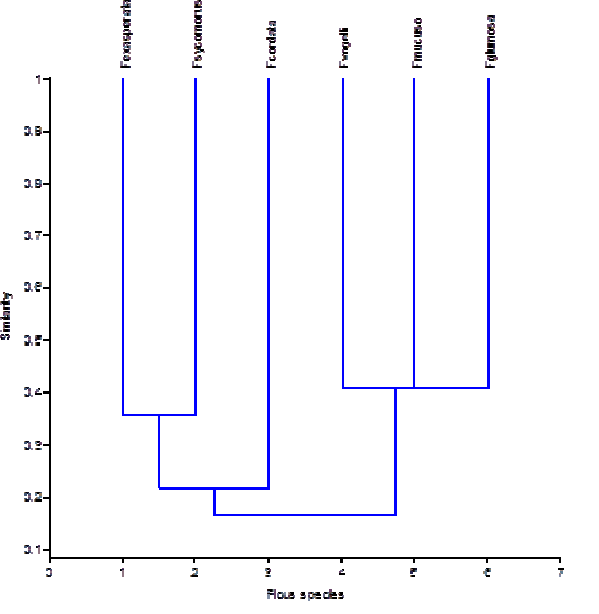
Fig. 2b. Dendrogram showing the chemotaxonomic relationship among six Ficus species from ethanolic